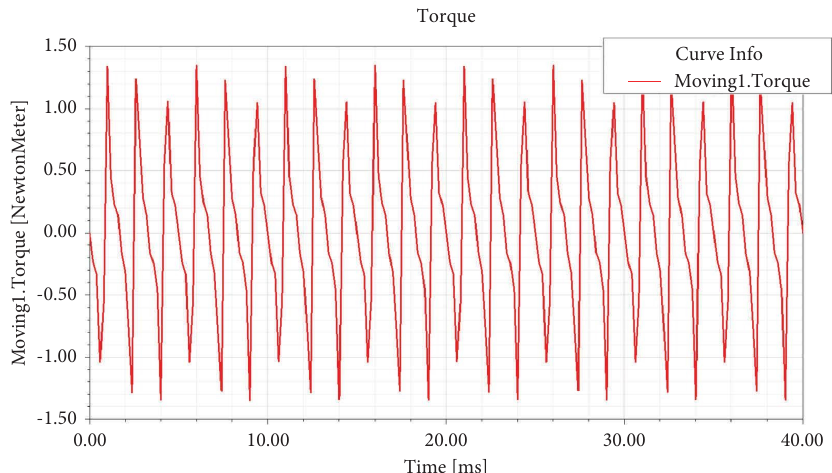
Moving1.TorqueCurve Info